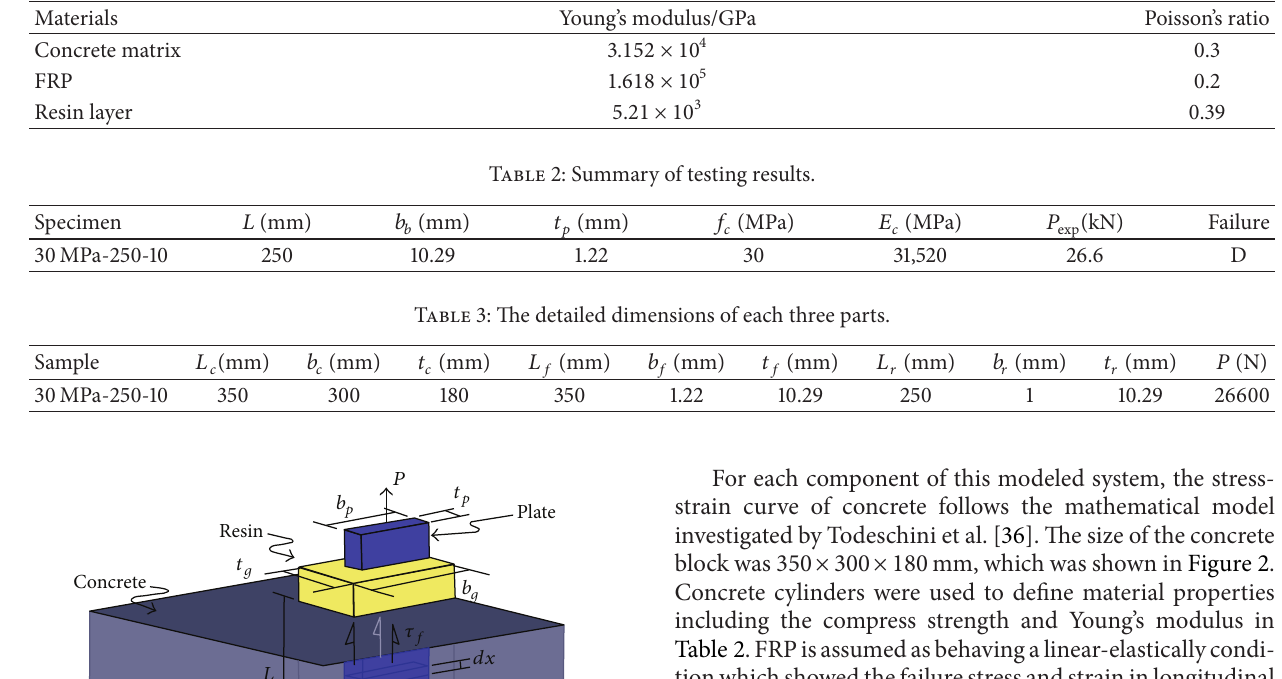
Table 1: Young’s modulus and Poisson’s ratio of three analyzed parts.